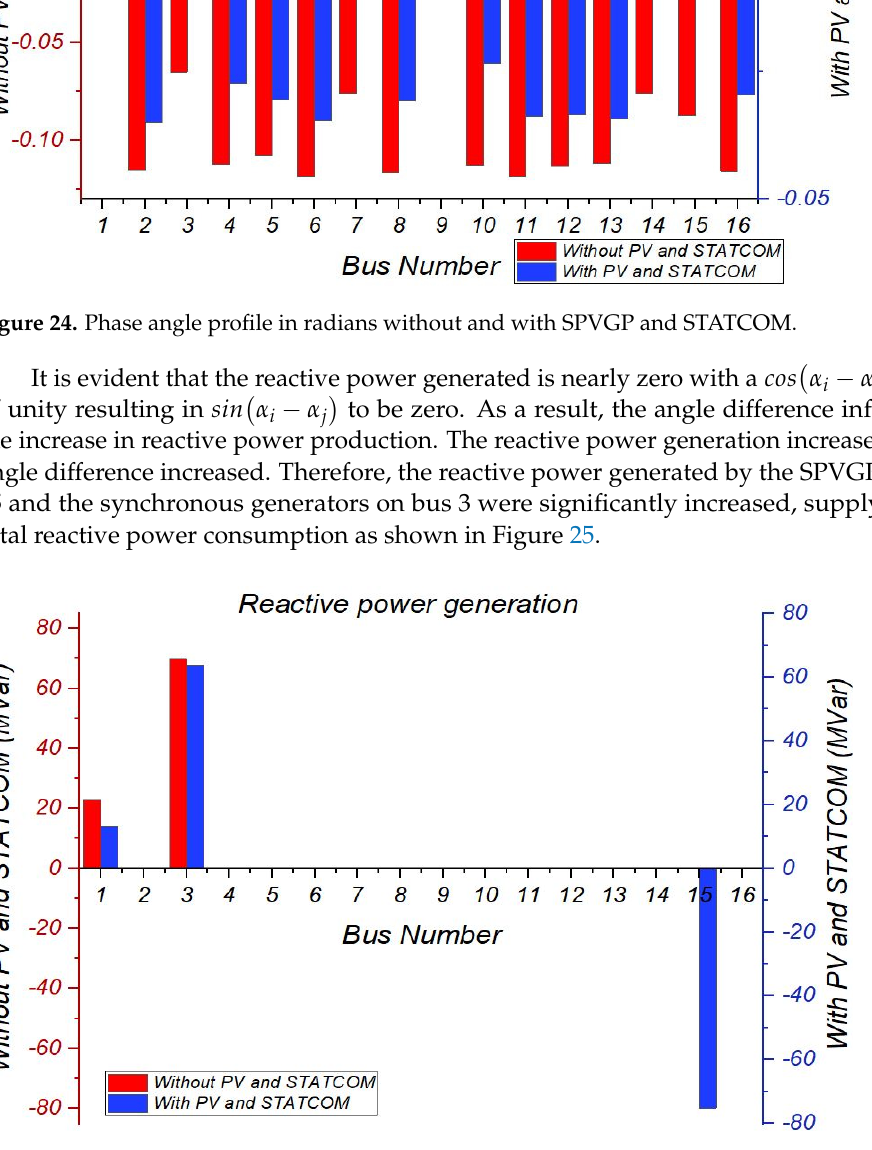
Figure 26. Active power generation without and with SPVGP and STATCOM. 6.2. Dynamic Performance Analysis This section presents and analyzes the transient responses of PV plants integrated into the grid and the synchronous generators of the considered power system network under faults. The system’s performance was assessed using the SAGC mandate. Worst ‐ case scenarios were considered in this regard. Initially, a base case in time domain simu ‐ lation was executed with the maximum solar PV power penetration. Laterally, the